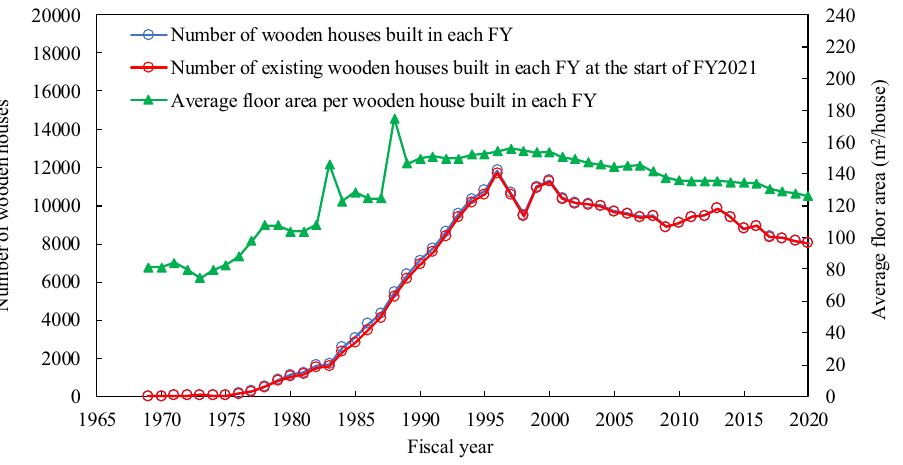
Figure 4. Number of wooden houses and average floor area per house built by the target